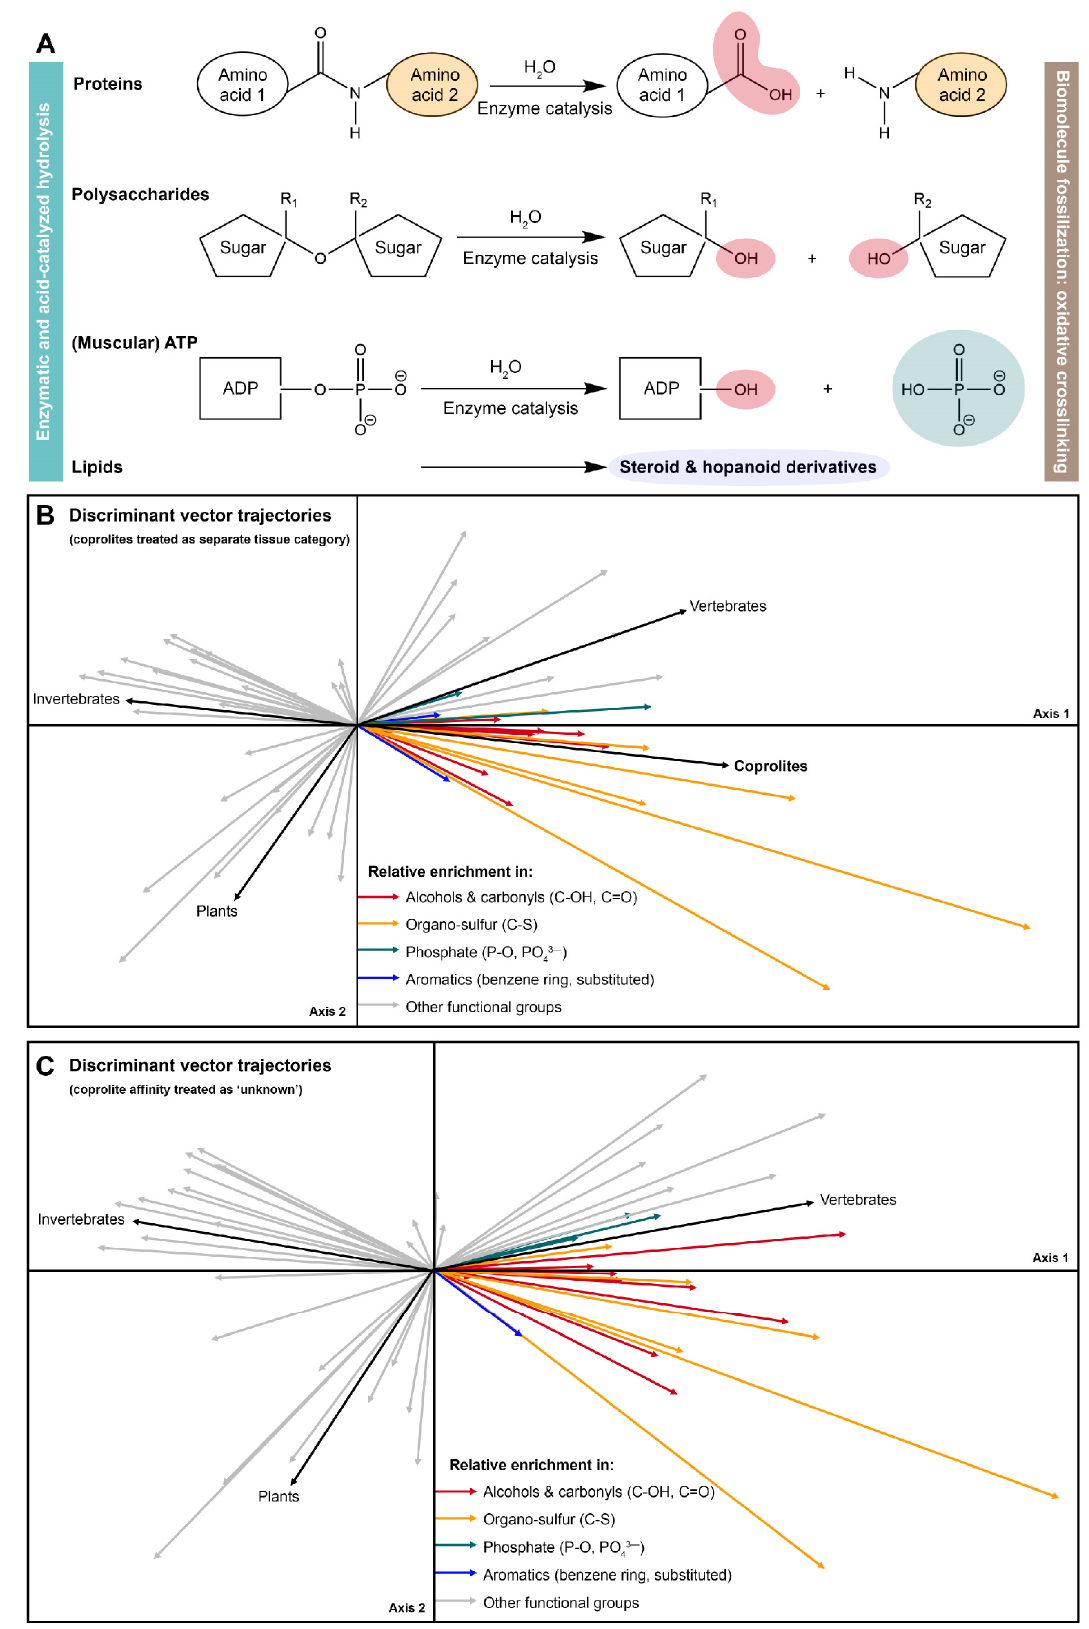
Figure 5. In vivo digestive hydrolysis reactions of key macromolecules and functional group